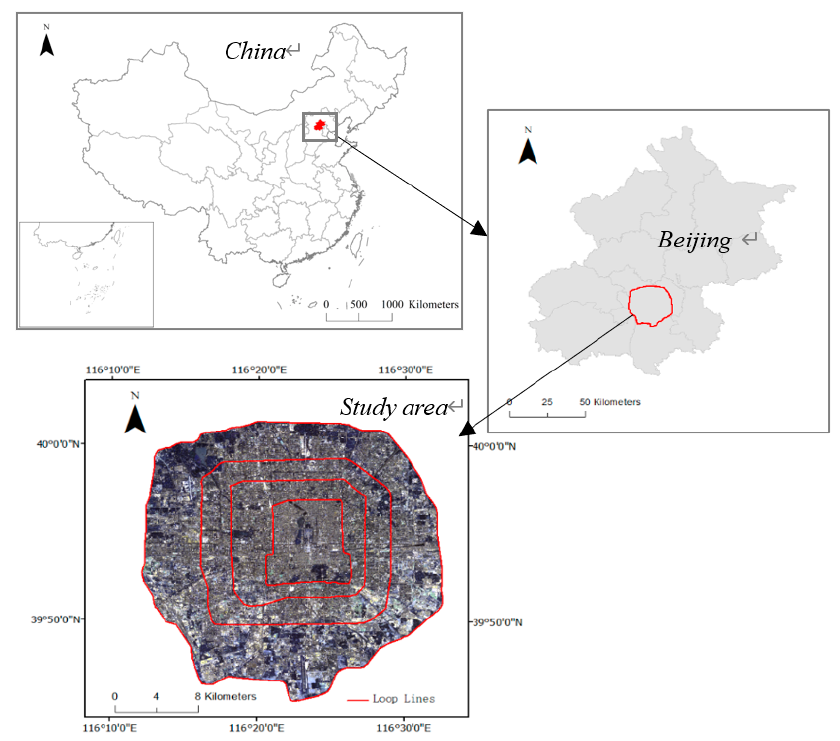
Figure 1. The location of the study area.